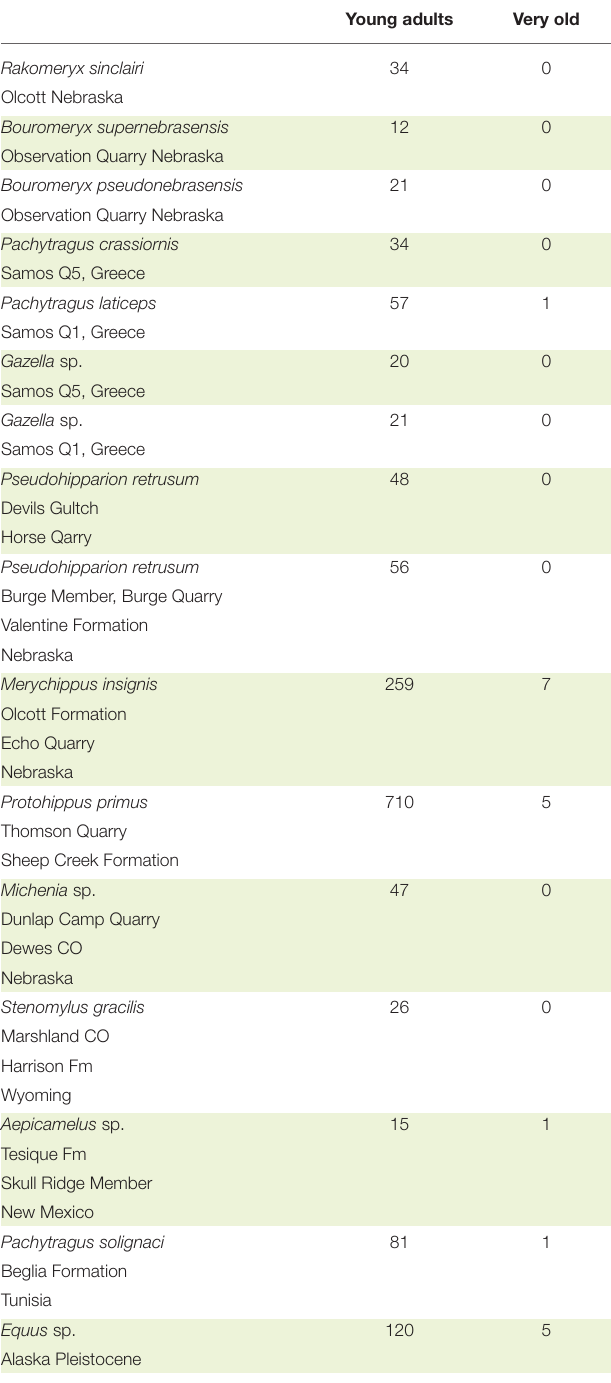
TABLE 2 | Brief survey of number of young adults vs. very old for selected taxa of Dromomerycidae, Bovidae, Equidae, and Camelidae from the